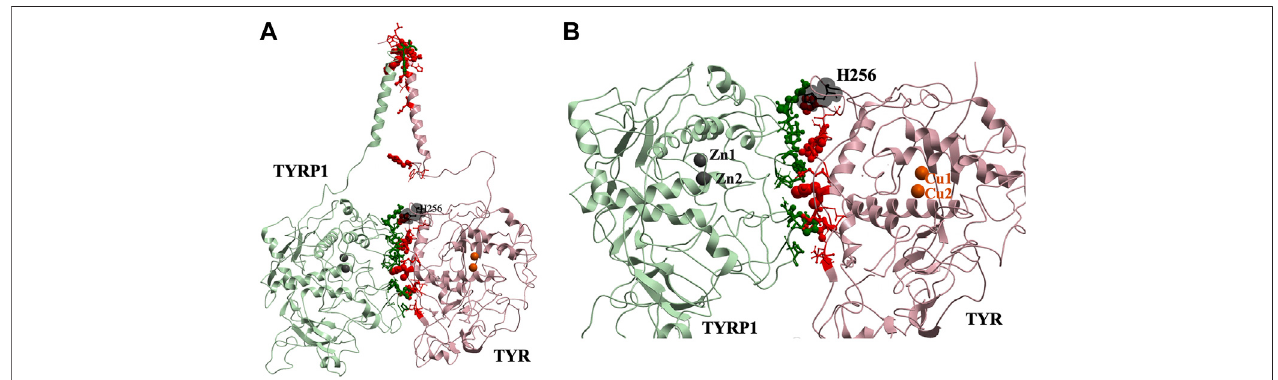
FIGURE 2 | Protein-protein interaction surface between TYR and TYRP1. Residues making key contacts are displayed in ball-and-stick (radius represents contributionsize). (A) .Fullsizedimer withhelix bundle. (B) .24contactresidues highlightedattheinterfaceofthetwoproteins.H256residuewhere mutationassociated with OCA1A occurs, is shown in black. Two Zn atoms in the active site of TYRP1 are shown in gray. Cu atoms in the active site of TYR are shown in orange.